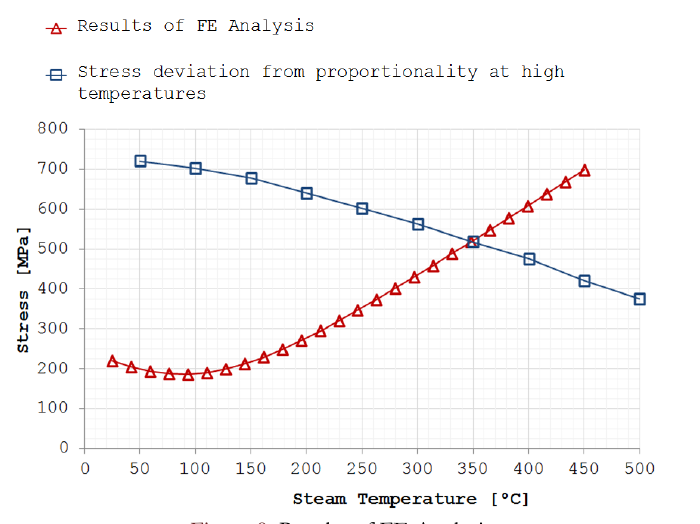
Figure 9: Results of FE Analysis.